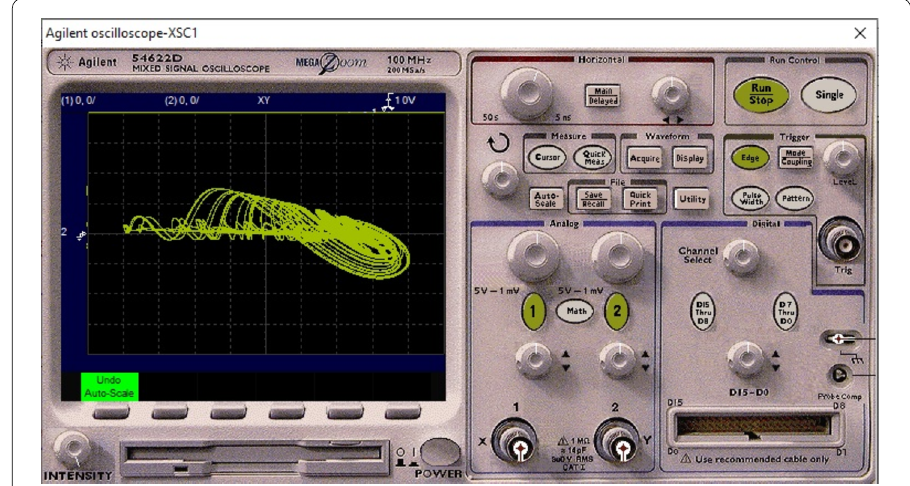
Figure 18 The plot of Z 3 versus Z 1 from the electronic circuit